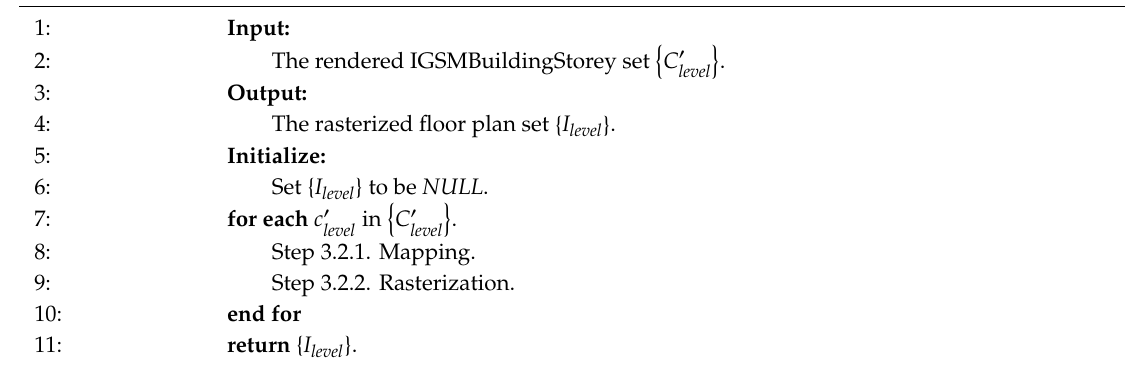
Algorithm 5. Mapping and Rasterization